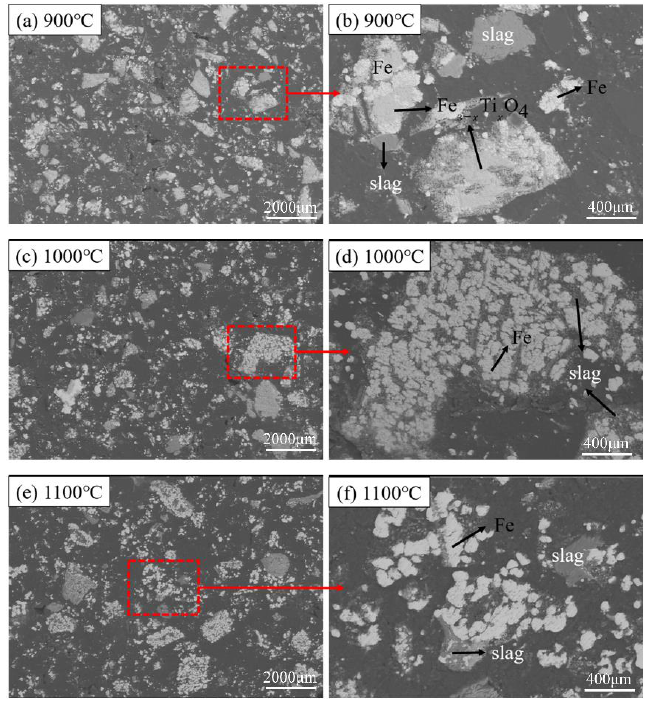
Figure 8. Microstructural characterization of samples on different reduction temperatures; ( a , b ) 900 °C; ( c , d ) 1000 °C; and ( e , f ) 1100 °C.